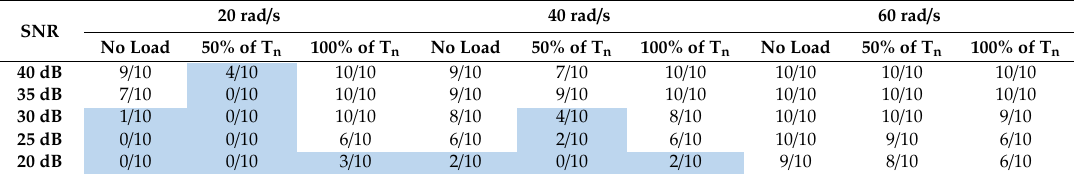
Table 2. Statistical moments of detection performances with P D >